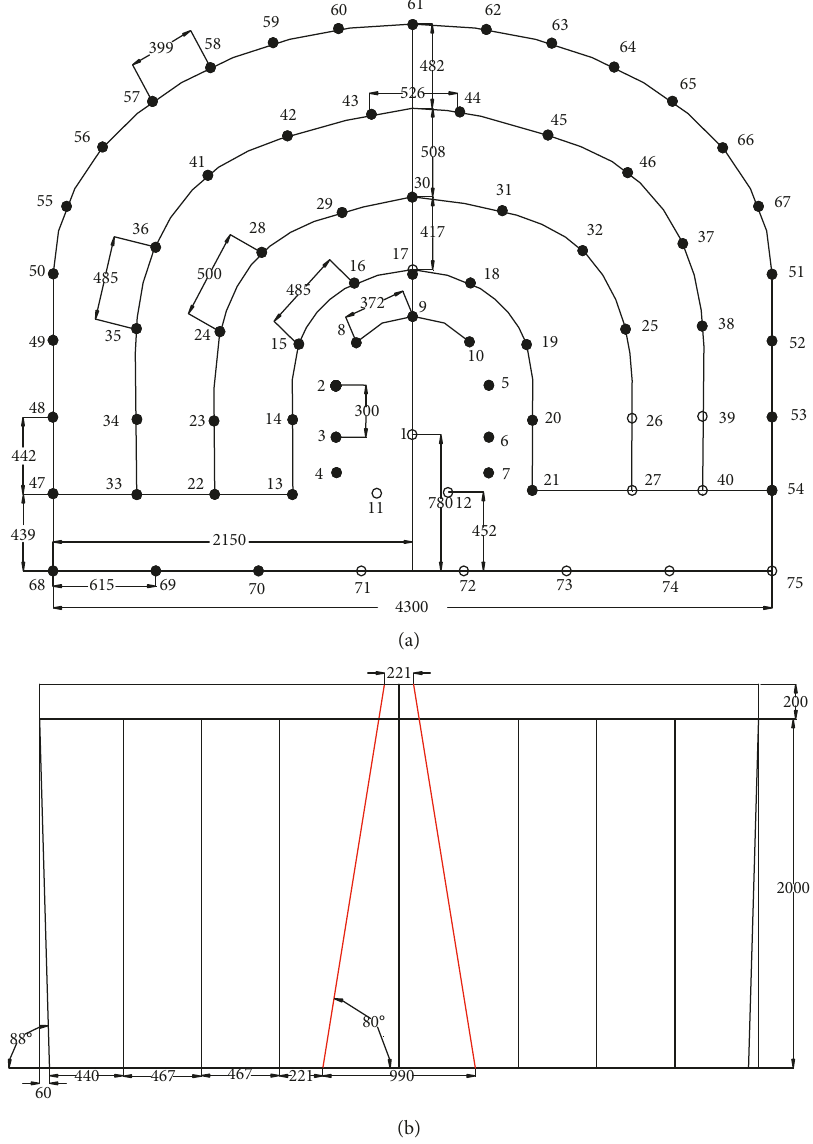
Figure 4: Blasting scheme of single-wedge hole cutting (unit: